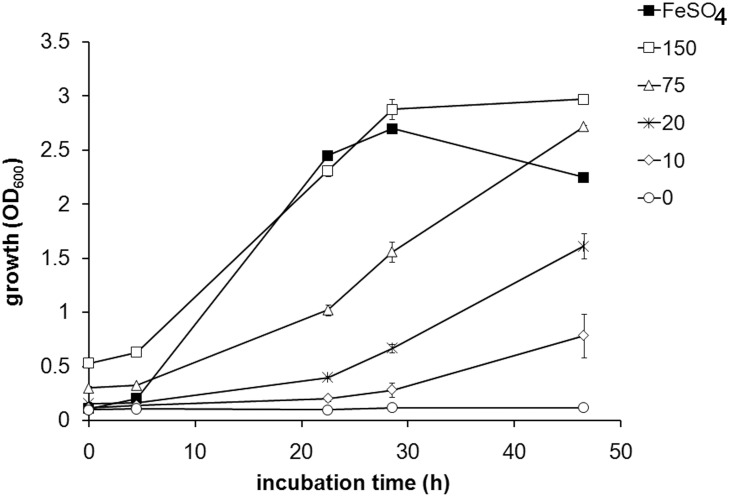
Growth of iron-depleted SCHU S4 in C-CDM supplemented with indicated concentrations of heme (open symbols) or 26 μM FeSO4 (closed symbol)